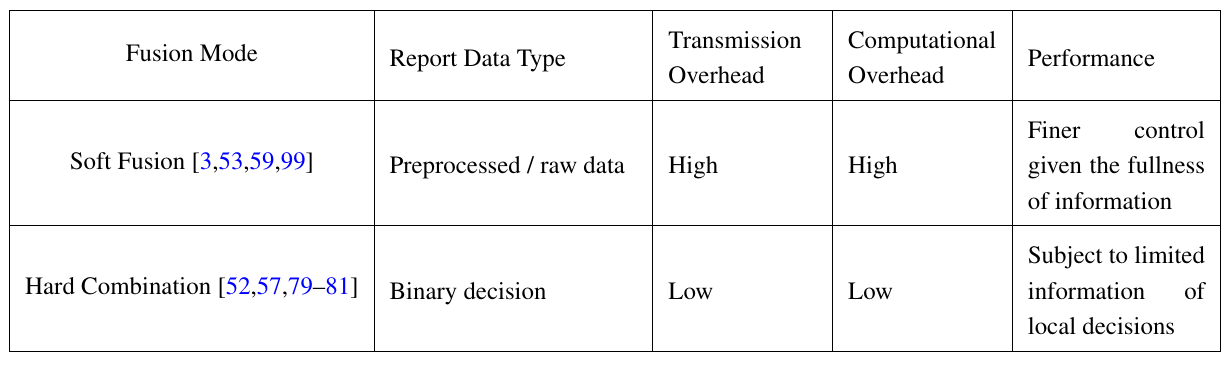
Table 5. Soft fusion vs. hard